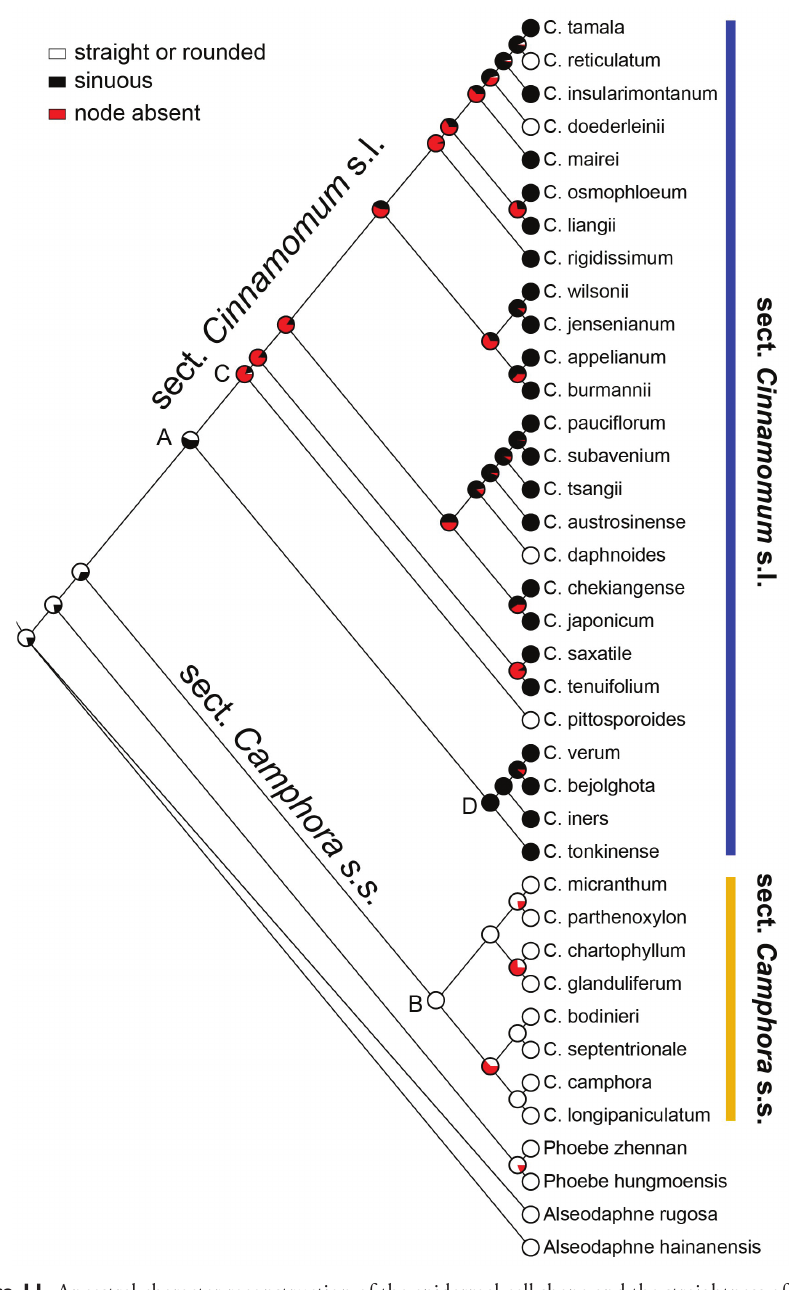
Figure 11. Ancestral character reconstruction of the epidermal cell shape and the straightness of anticli- nal wall by applying a ML tree block in Mesquite with a maximum likelihood approach and MK1 model. Node A: the ancestral node of sect. Cinnamomum s.l. had sinuous anticlinal walls and irregular cell shapes or not, the probability being only 56.54%; Node B: the ancestral node of sect. Camphora s.s. possessed straight or curved anticlinal walls and polygonal cell shapes, the probability being